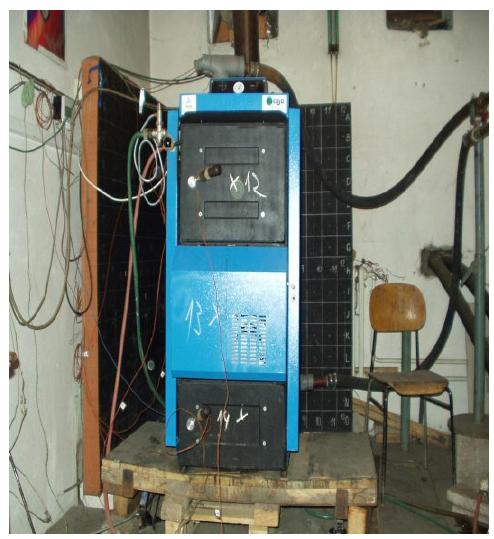
Figure 1. MA 23 hot-water boiler—connection of measuring probes.